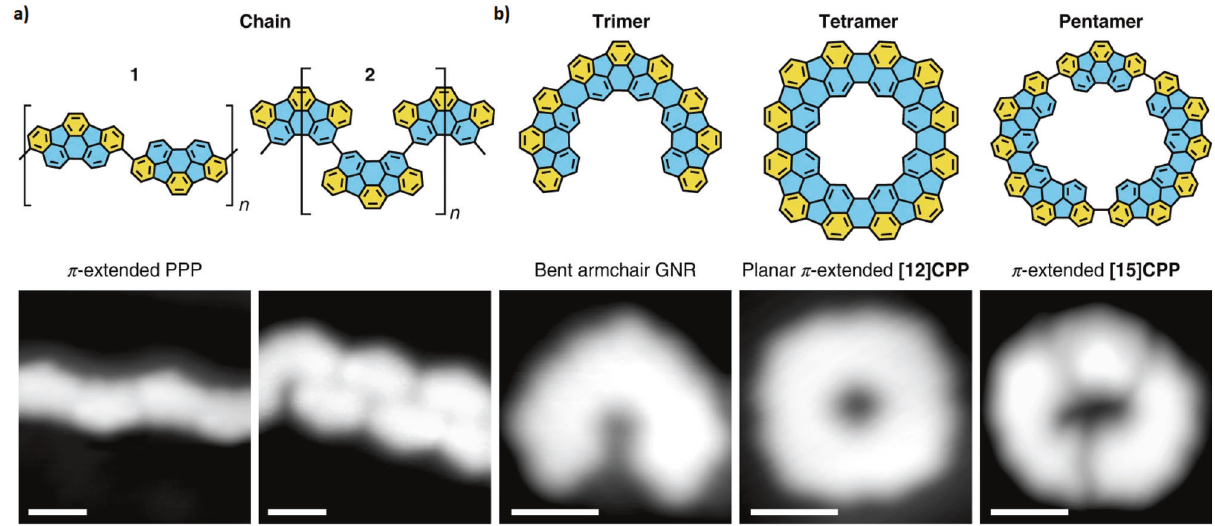
Fig. 1 Atomically precise carbon nanostructures formed by Ullmann-type coupling of dibrominated indacenopicene precursors followed by cyclodehydrogenation on Au(111). Trans coupling leads to π -extended polyparaphenylene chains ( a ), while cis coupling affords bent armchair graphene nanoribbons (trimers), planar π -extended [12]CPPs (tetramers) and π -extended [15]CPP (pentamers) ( b ). Micrographs are high-resolution scanning tunneling microscopy images, with scale bars 1 nm. Reprinted by permission from Springer Nature: Nat. Chem., copyright